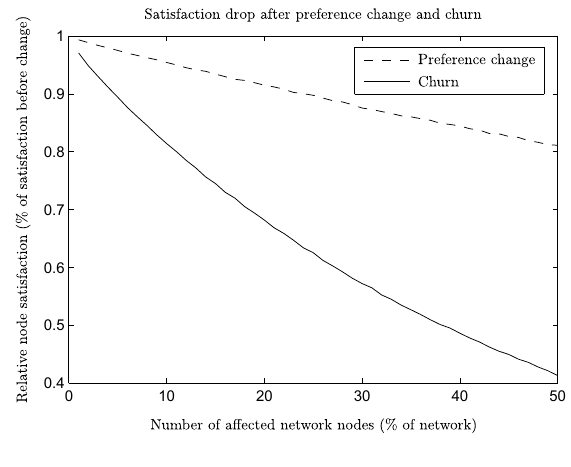
Figure 10. Satisfaction right after preference change or churn per amount of affected